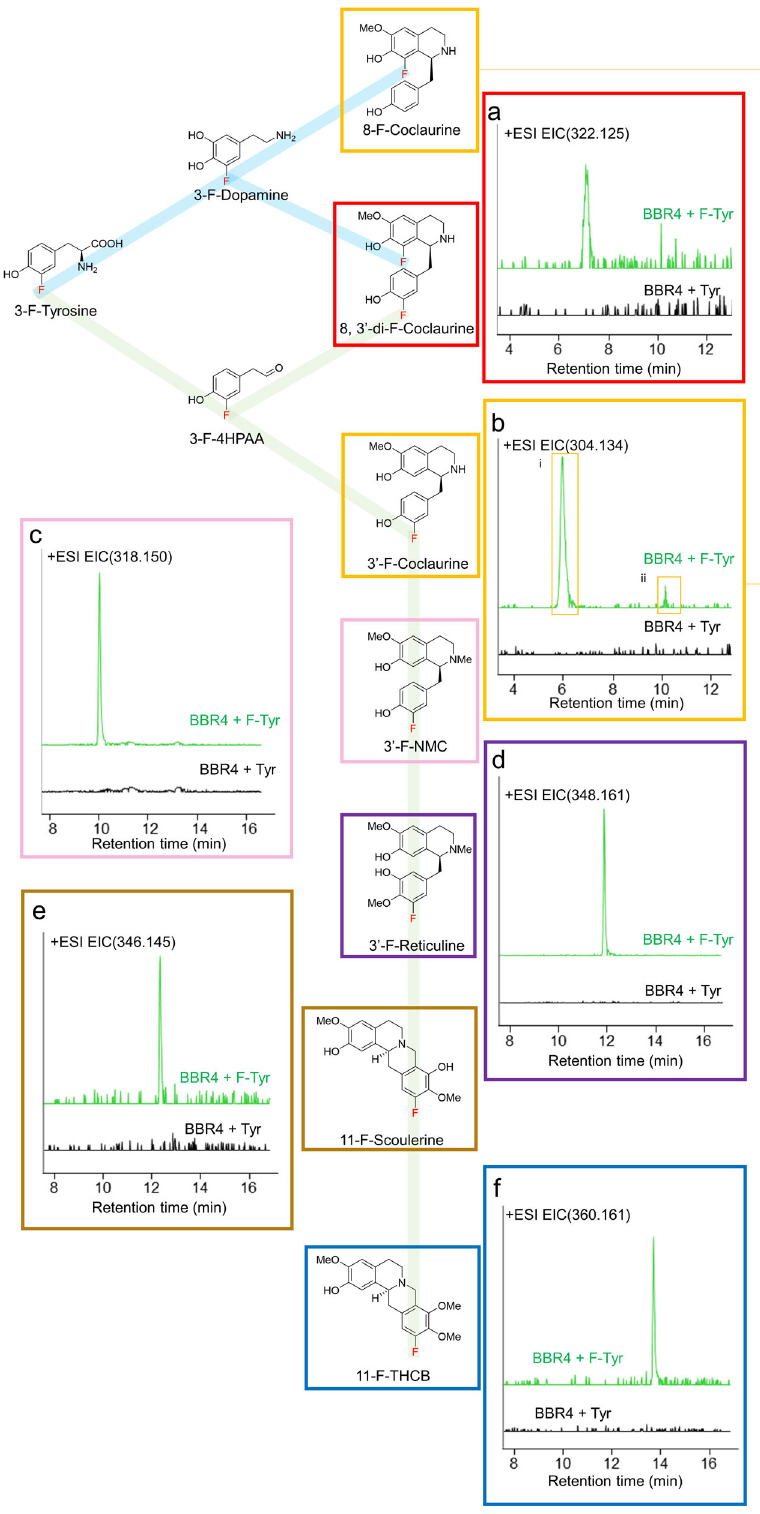
Fig. 4 Production of F-substituted BIAs in BBR4R from 3-F-tyrosine feeding. Schema of proposed semi-biosynthetic pathway of F-BIAs from 3-F- tyrosine. Dopamine route (blue line) and 4HPAA route (green line) are shown. The high-resolution EIC of ( a ) 8, 3 ’ -di-F-Coclaurine, ( b ) i) 8-F-Coclaurine, ii) 3 ’ -F-Coclaurine, ( c ) 3 ’ -F-NMC, ( d ) 3 ’ -F-Reticuline, ( e ) 11-F-Scoulerine, ( F ) 11-F-THCB. The EIC was extracted using the calculated m/z of target compounds (M + H) + , with a mass accuracy below 100 ppm. Traces are representative of three biological